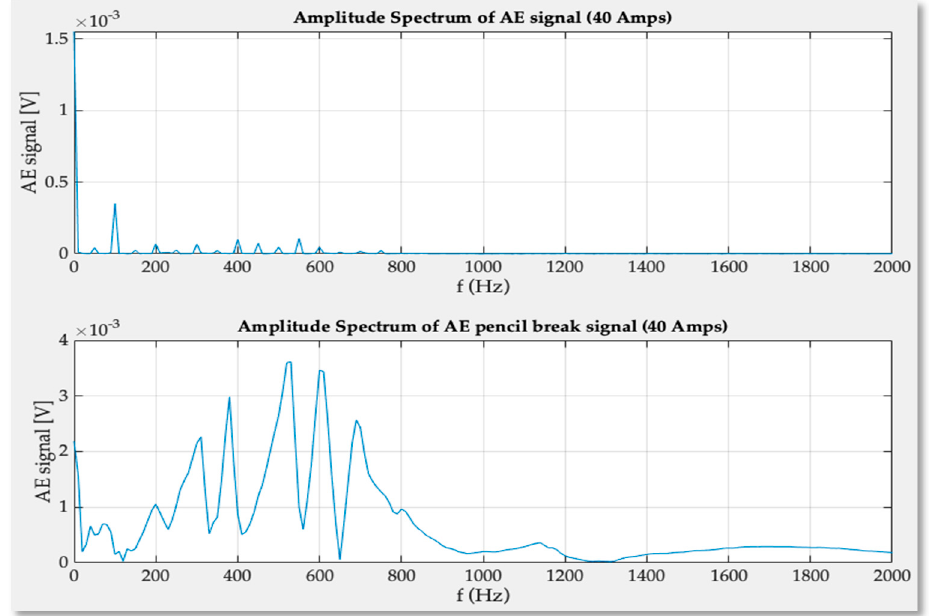
Figure 14. The frequency spectrum of signal recorded for 40 amperes anode-cathode rectified current ( upper ) and pencil lead break test effects in the presence of 40 A current ( lower ).